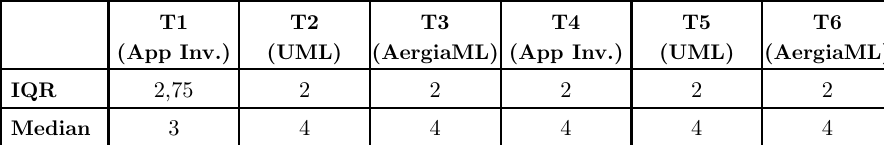
Table 1. The IQR and median of marks given during tasks